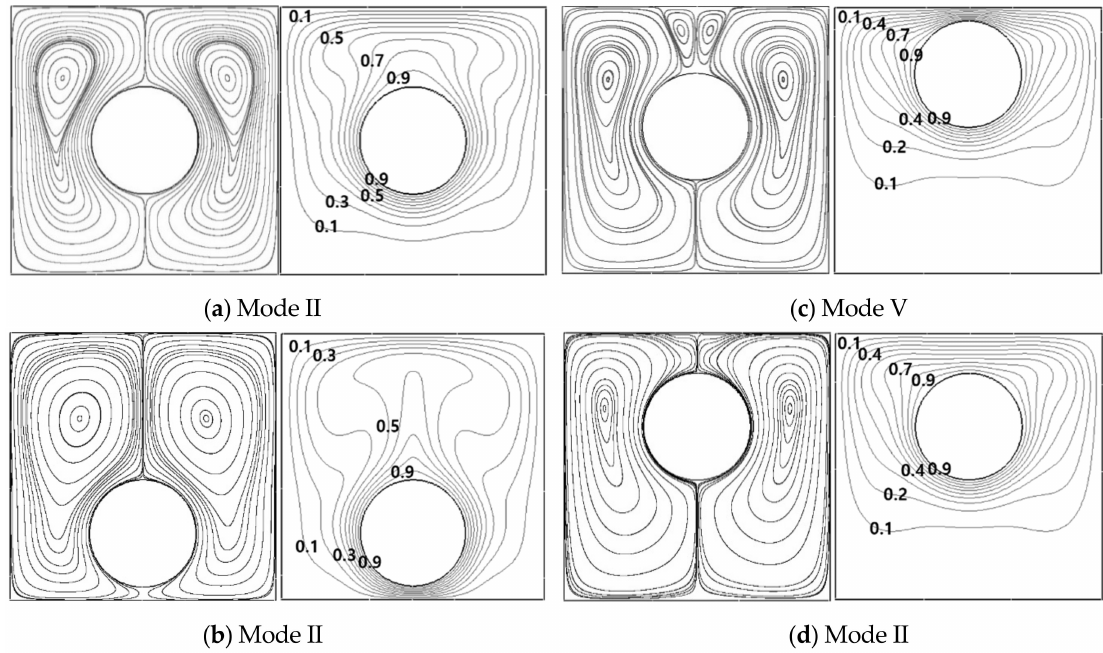
Figure 14. Streamlines (left column) and isotherms (right column) at ( a ) ( r = 0, θ = 0 ◦ ), ( b ) ( r = 0.25 L , θ = − 90 ◦ ), ( c ) ( r = 0.05 L , θ = 90 ◦ ) and ( d ) ( r = 0.15 L , θ = 90 ◦ ) for Ra = 10 5 . The upward movement of the cylinder from ( r = 0, θ = 90 ◦ ) contributes to the presence of the new Mode V in the Map of the flow structure in Figure 13. When the cylinder moves upward from the enclosure center, the mode changes from Mode II to Mode V